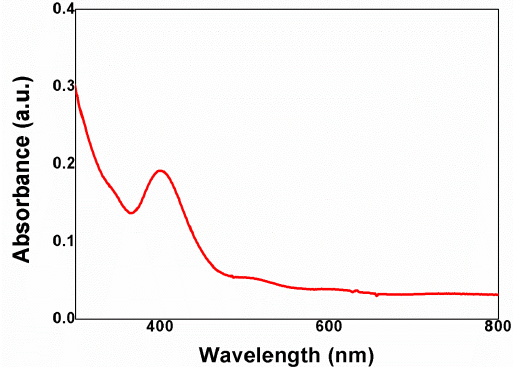
Figure 3. Ultraviolet-visible (UV-vis) spectrum of Ag NP-functionalized TiO 2 nanotubes.